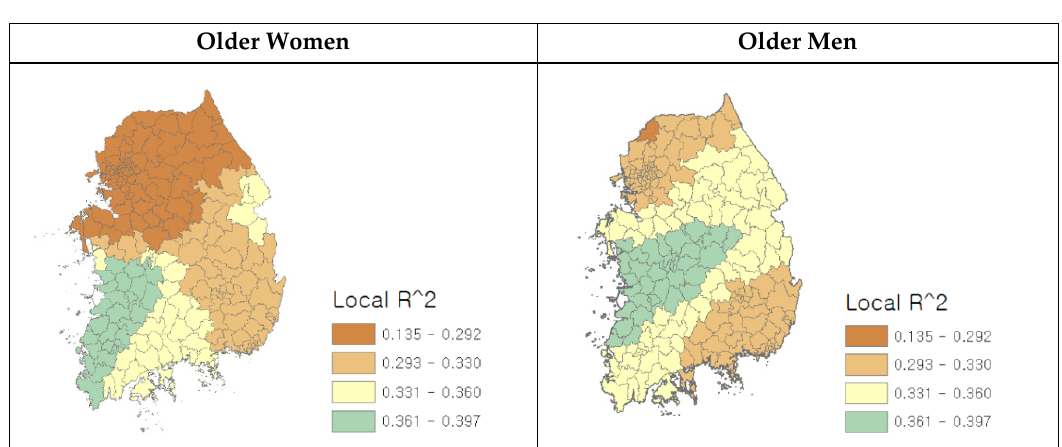
Figure 1. GWR model performance for older women and men: distribution of local R 2 values.